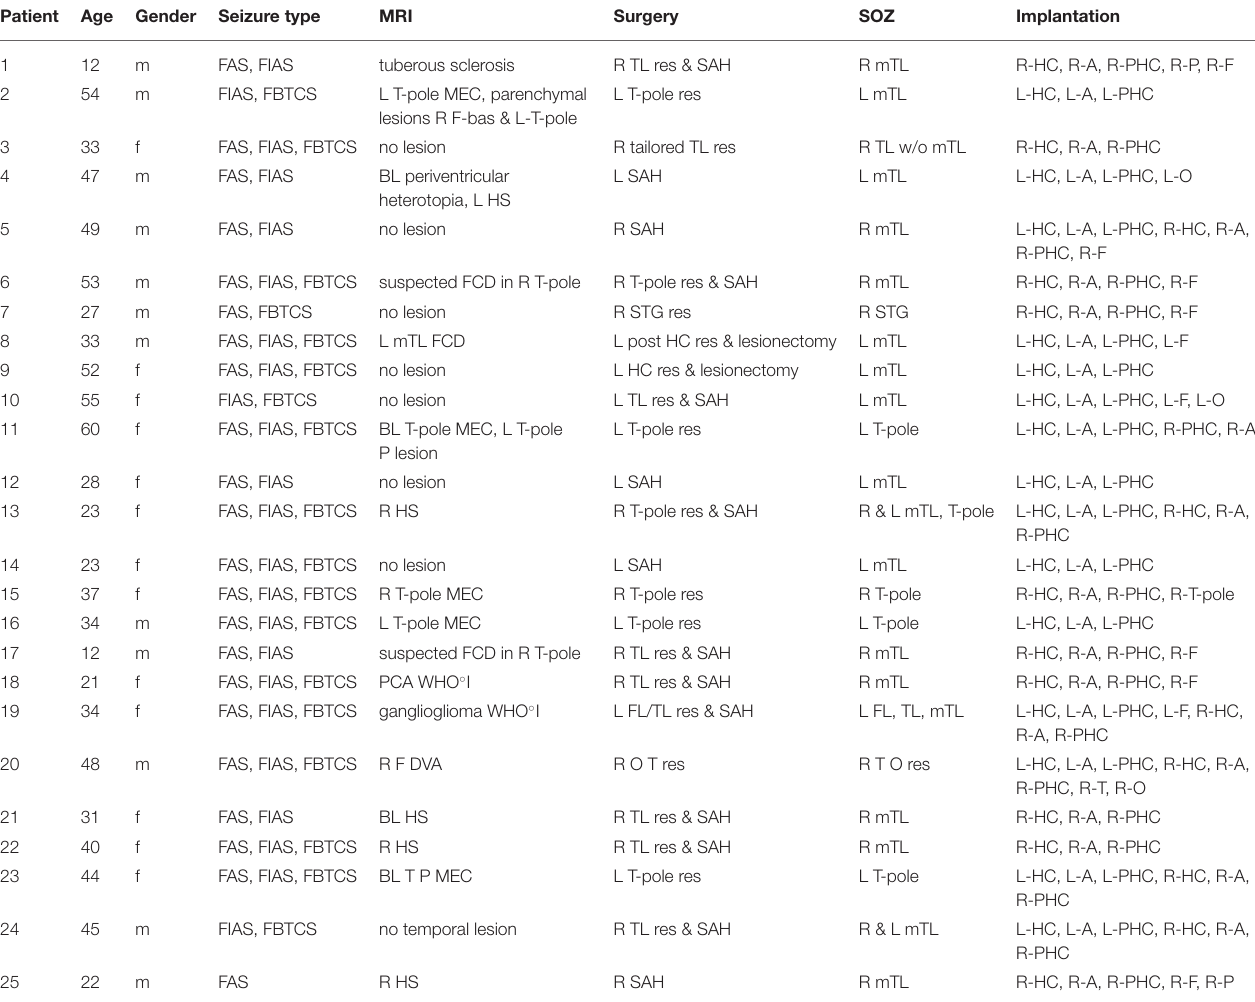
TABLE 1 | Clinical data. Patient Age Gender Seizure type MRI Surgery SOZ